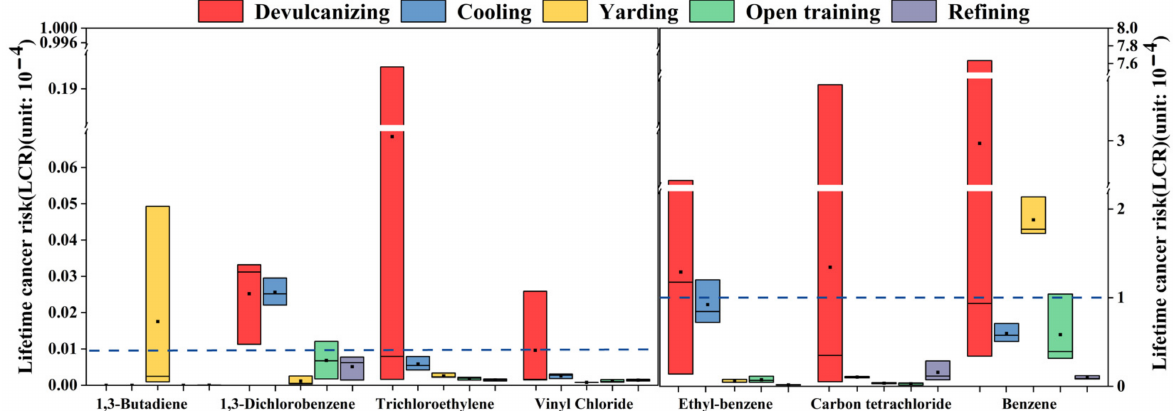
Figure 4. LCR value of compounds from each process. The box represented the 25–75th percentiles of LCR values. The middle square and middle line represented the mean and the median values of LCR values,